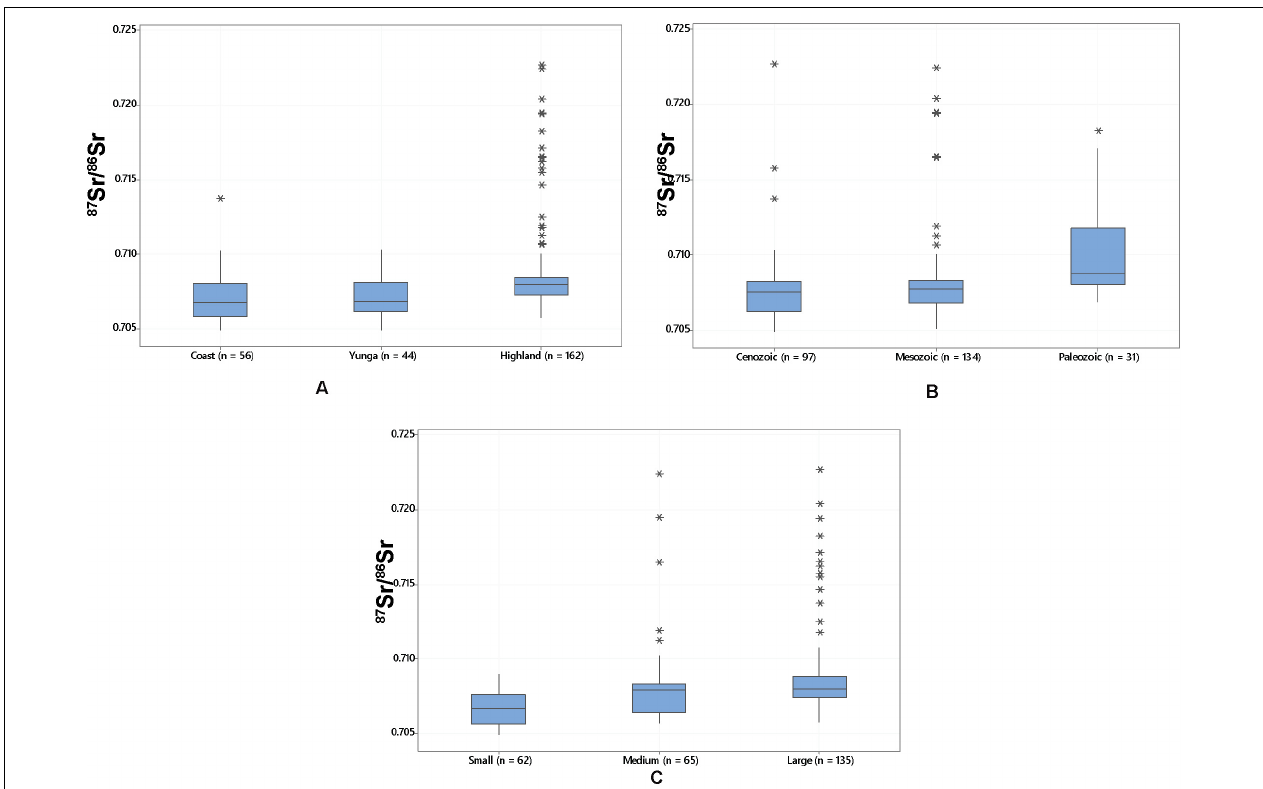
FIGURE 4 | (A) Boxplot of 87 Sr/ 86 Sr ( n = 262) from coastal, yunga , and highland elevations; (B) Boxplot of 87 Sr/ 86 Sr from small, medium, and large watersheds (hectares); and (C) Boxplot of water 87 Sr/ 86 Sr overlying geological units from the Cenozoic, Mesozoic, and Paleozoic eras (from most recently to oldest deposited